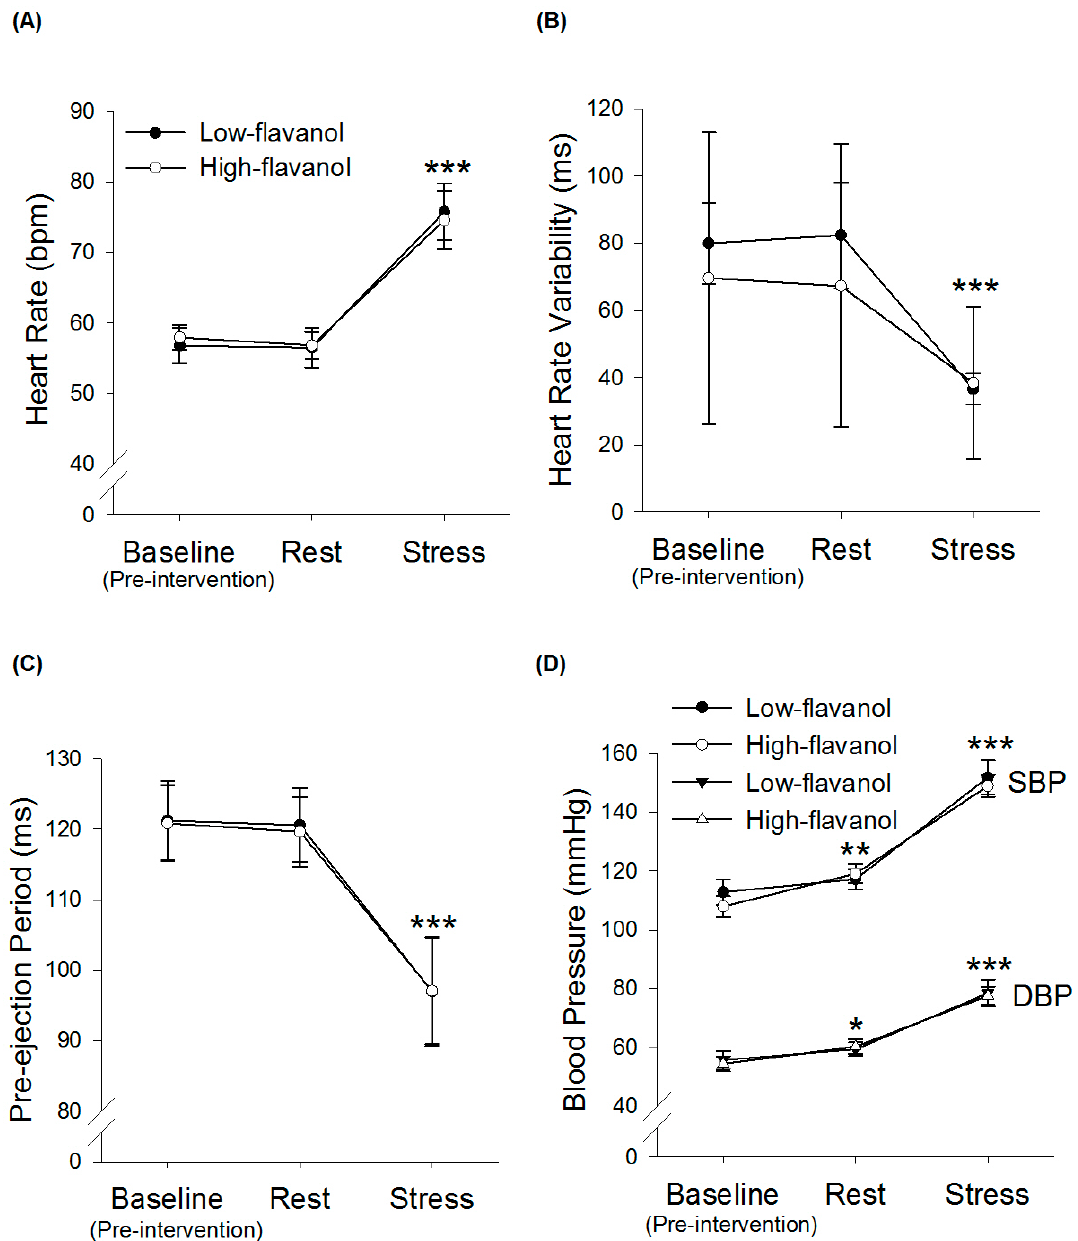
Figure 2. Time course of Heart rate ( A ), Heart rate variability ( B ), Pre-ejection period ( C ) and Systolic and Diastolic blood pressure (SBP, DBP) ( D ) before (pre-intervention baseline) and following either a high-flavanol cocoa or low-flavanol cocoa, at rest and during stress (8-min PASAT). Data are presented as Mean ± SEM. Post-hoc analyses were conducted using Bonferroni’s multiple comparison test. *** HR, HRV, PEP, SBP and DBP were significantly different during stress, compared to rest and pre-intervention baseline, for both conditions ( p < 0.001). ** SBP was significantly greater during rest compared to pre-intervention baseline ( p < 0.01). * DBP was significantly greater during rest compared to pre-intervention baseline ( p < 0.05). (N = 10–13 for HR, HRV and PEP; N = 30 for BP).HR, heart rate; HRV, heart rate variability; PEP, pre-ejection period; SBP, systolic blood pressure; DBP, diastolic blood pressure; BP, blood pressure, PASAT, paced-auditory-serial-addition-task, SEM, standard error of mean